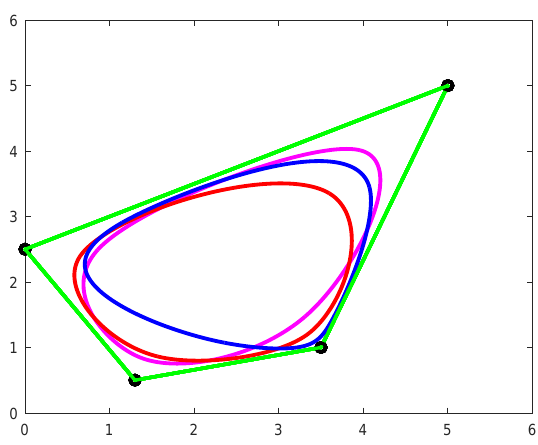
Figure 16. Closed TRBS curve with different